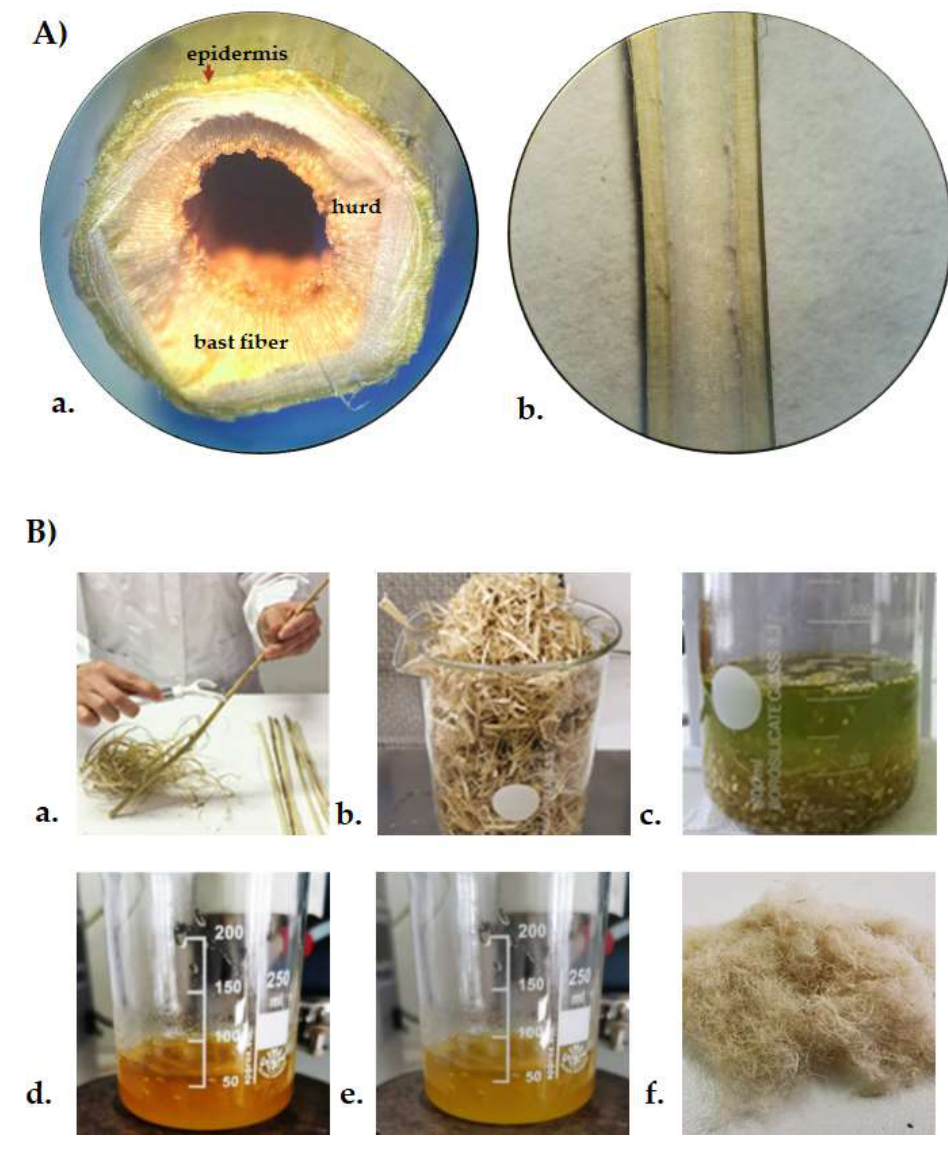
Figure 1. ( A ) Hemp Stem (a) transversal section; (b) longitudinal section; ( B ) Hemp cellulose extraction steps. (a) Hemp stem peeling; (b) Ultrasound-assisted maceration; (c) Alkaline treatment; (d) Acid hydrolysis; (e) Hemp cellulose recovery; (f) Representative cellulose sample.